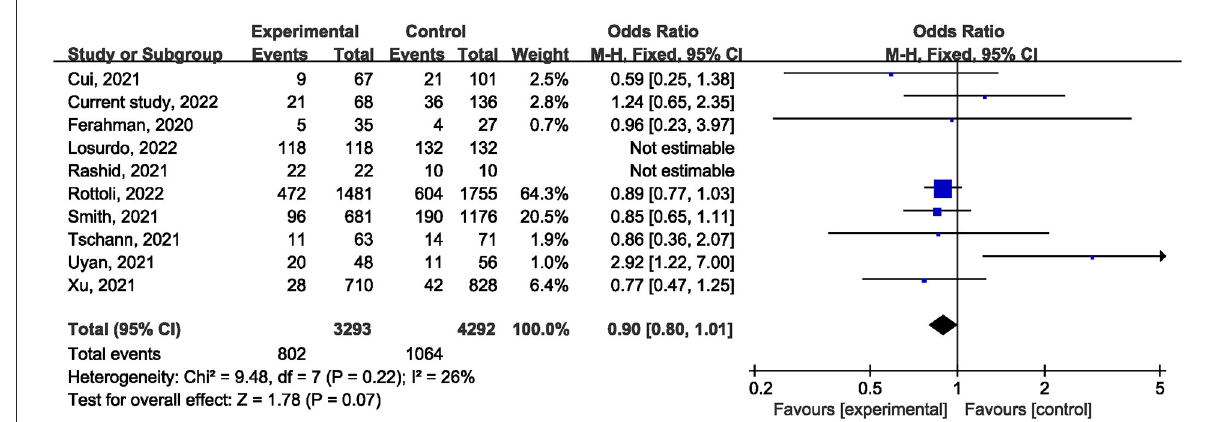
FIGURE1 The impact of the COVID-19 pandemic on postoperative morbidity.